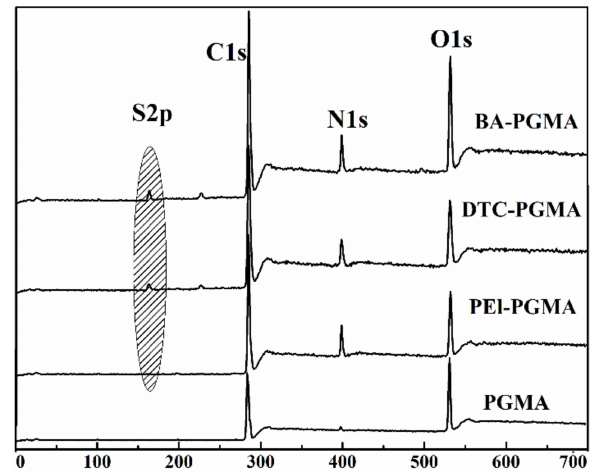
Figure 2. X-ray photoelectron spectroscopy (XPS) survey scan of PGMA, PEL-PGMA, DTC-PGMA, and BA-PGMA.